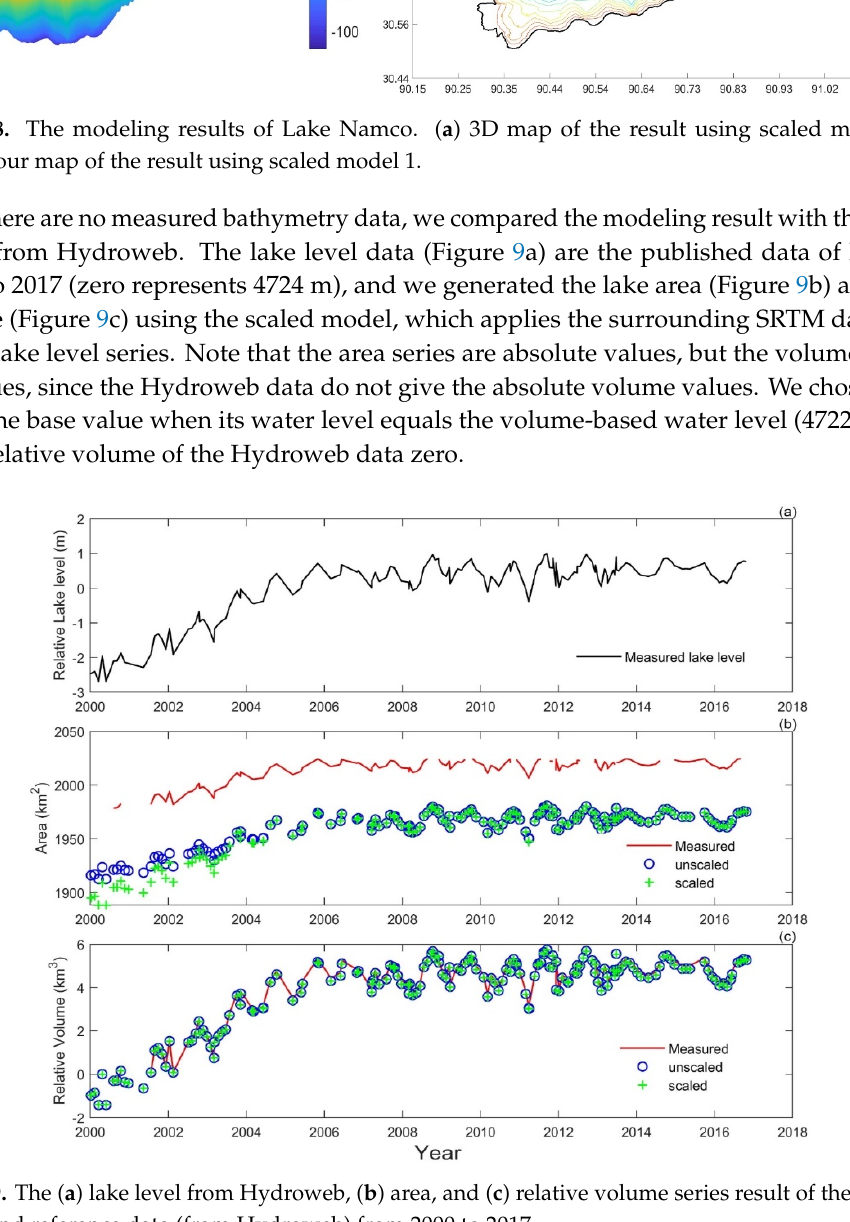
Figure 8. The modeling results of Lake Namco. ( a ) 3D map of the result using scaled model 1; ( b ) contour map of the result using scaled model 1.